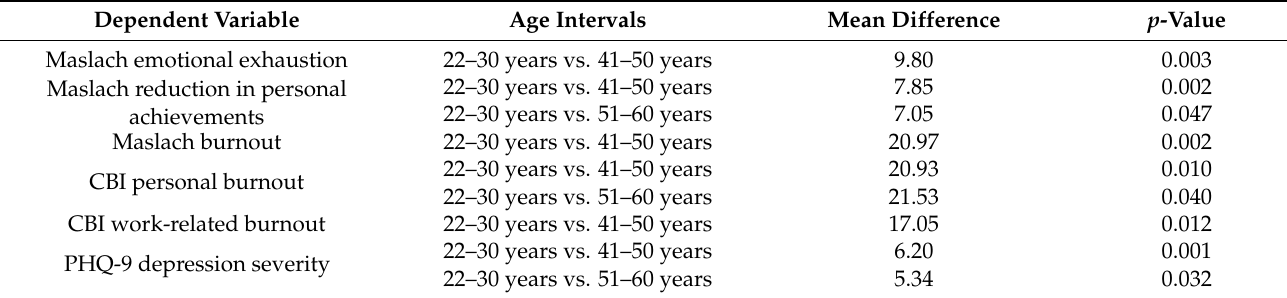
Table 7. Multiple comparisons of means between different age groups.